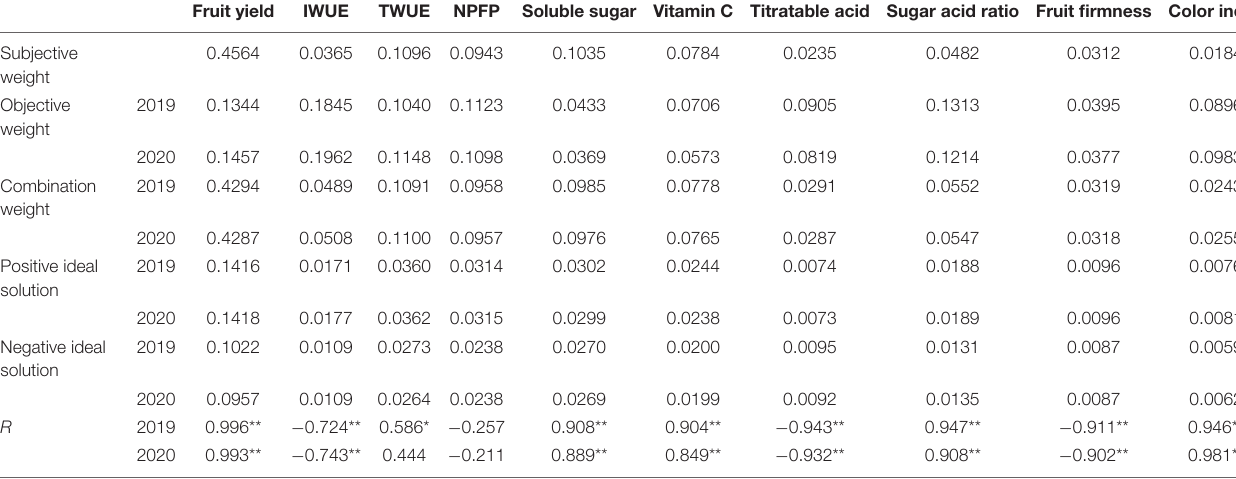
TABLE 4 | Weight and ideal solution of the TOPSIS method, and correlation coefficient between the comprehensive evaluation index and each evaluation index. Fruit yield